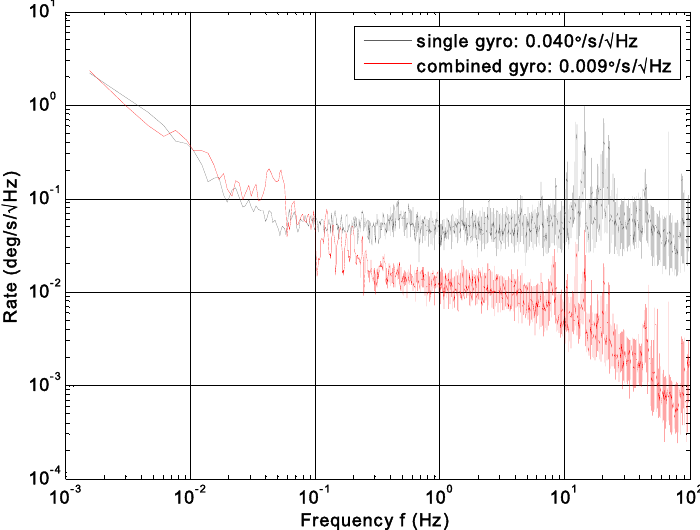
Figure 12. FFT plot of combined angular rate signal compared to the single